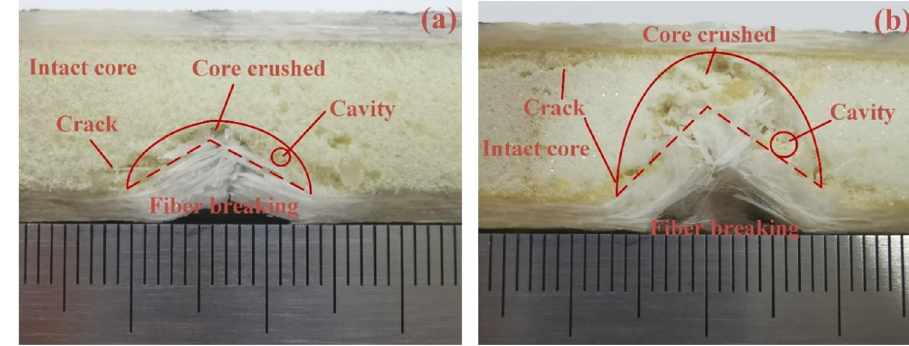
Figure 11: Typical damage modes: ( a ) without aging at 16 J and ( b ) 70°C – 30 days at 22